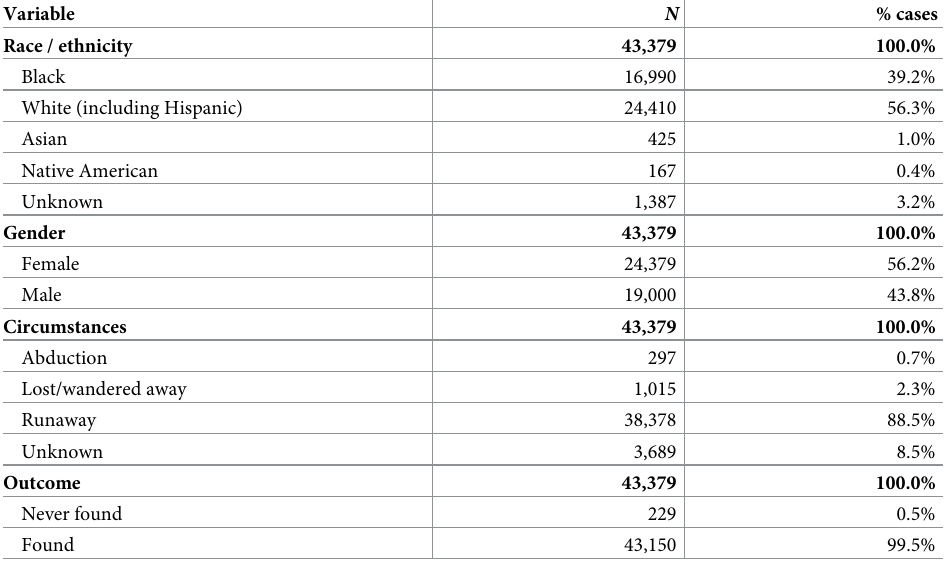
Table 2. Descriptive statistics for categorical